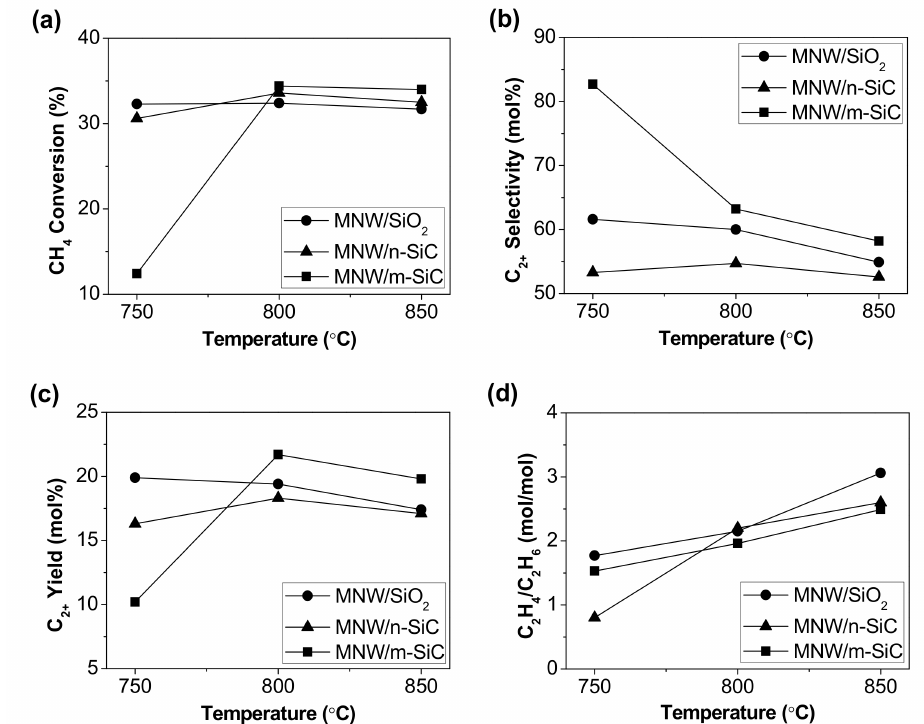
Figure 4. The catalytic activity for OCM reaction over MNW / n-SiC, MNW / m-SiC, and MNW / SiO 2 catalysts as a function of temperature. ( a ) CH 4 conversion; ( b ) C 2 + selectivity; ( c ) C 2 + yield; and ( d ) C 2 H 4 / C 2 H 6 ratio (feed composition: CH 4 / O 2 / N 2 = 3 / 1 / 1, GHSV = 10,000 h − 1